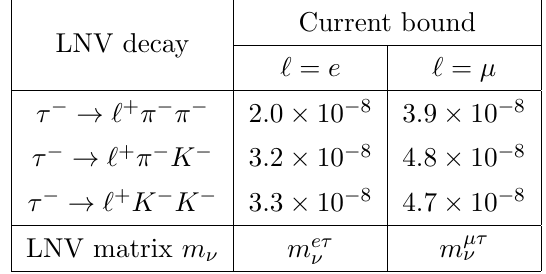
Table 5 . LNV (cid:28) decay processes. The upper bounds are from the Belle collaboration [87].